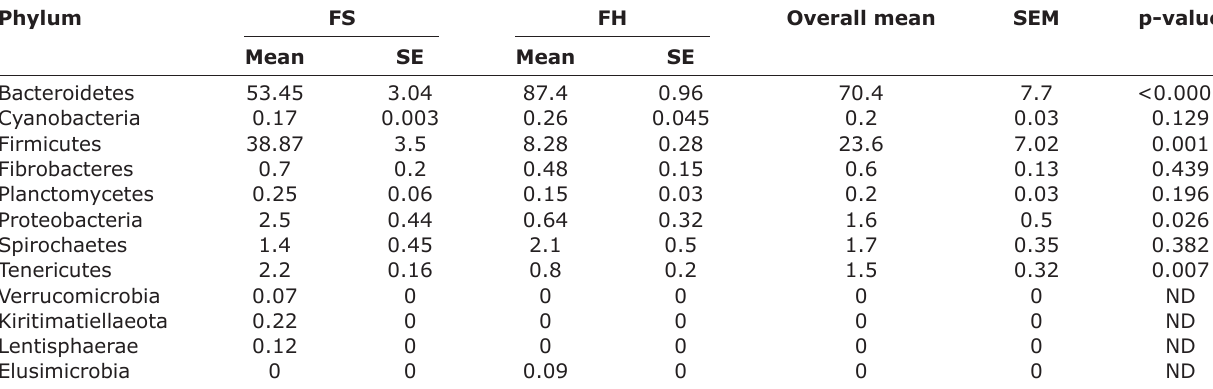
Table-5: The relative abundances (%) of bacterial phyla in the rumen of camels fed different forages. Phylum FS